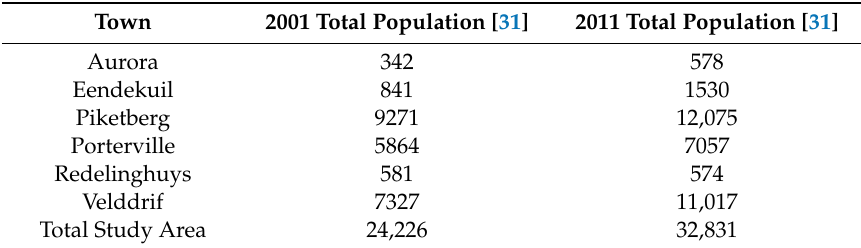
Table 1. Population changes by town.